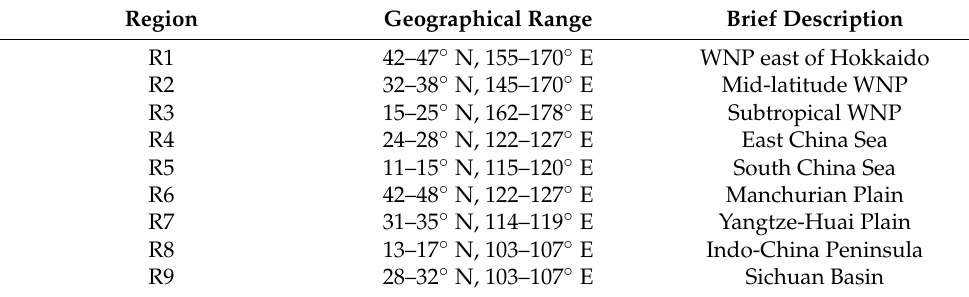
Figure 1. Terrain heights (color shading, unit: km) of the study area. Nine regions of interest are outlined by red rectangles. Table 1. Latitudinal and longitudinal ranges of the nine regions of